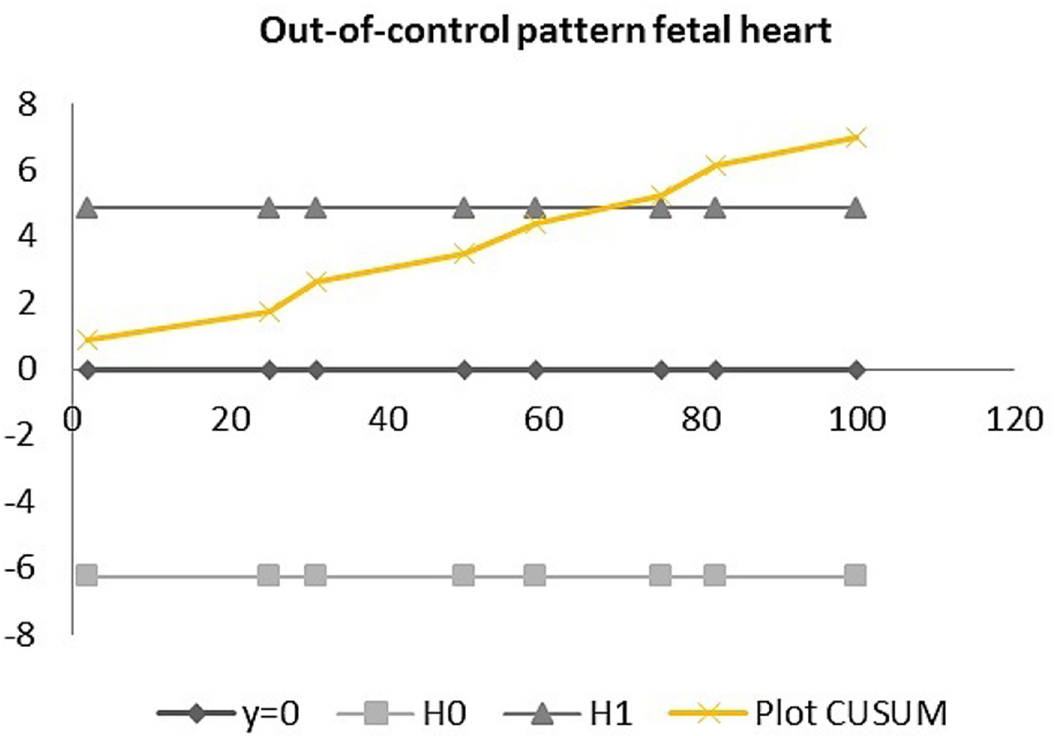
Fig 2. CUSUM analysis showing an out-of-control pattern for the fetal heart. Where y = 0 represents the 13-week anomaly scans performed by the sonographers throughout the study period. H0 and H1 represent, respectively, the lower and upper limits of the CUSUM graph, which should not be crossed by the CUSUM plot (in yellow) for the process to not go out of control. CUSUM represents the learning curve obtained by CUSUM analysis. In this case the CUSUM line crosses the upper limit, therefore showing an out of control pattern and thus no clear change in performance.